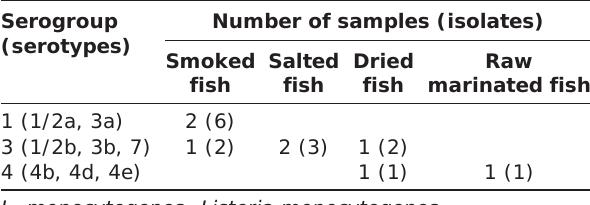
Table-2: Distribution of the serotypes in the 15 strains of L. monocytogenes isolated from RTE seafood. Serogroup